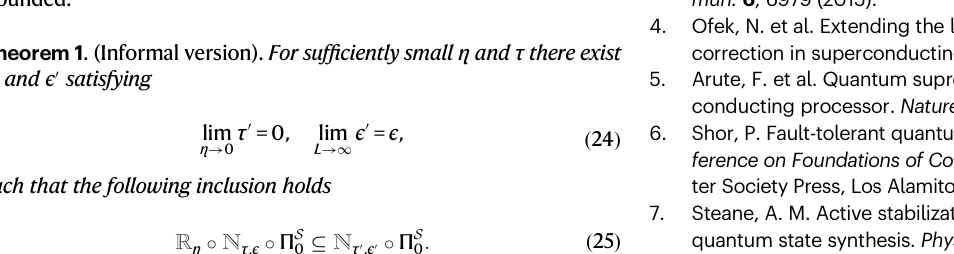
afunctionoflog p = p th fordifferentvaluesofthecodedistance D .We fi tthedatato straight lines to obtain estimates of a as a function of D . c We plot log a = log α ð t Þ + β ð t Þ log D asafunctionoflog D and fi ttoastraightlinetoestimate α ( t ) and β ( t ). In each plot, the error bars show standard error